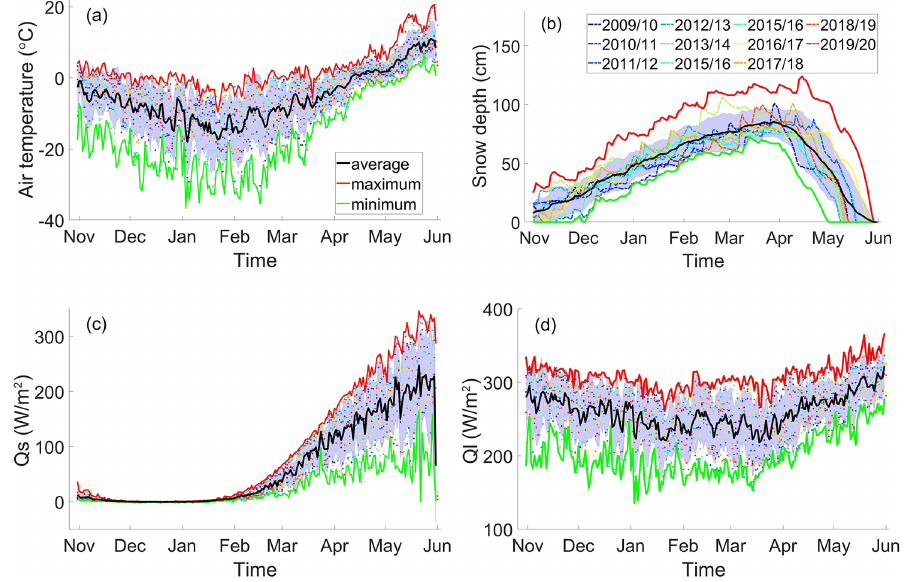
Figure 7. The observed (dots) daily mean air temperature (a) , snow depth (b) , downward shortwave radiative flux (c) , and longwave radiative flux (d) for each ice season between 1 November and 31 May. The solid lines represent decadal daily maximum (red), minimum (green), and average (black) values. The shadow area represents the standard deviation (SD). For snow depth, daily mean values are given as thin colour lines. Table 2. Summary of various meteorological and physical observations between 1 November and 31 May. For meteorological parameters ( V a , T a , RH, cn, Q s , Q l ) the values are seasonal mean ± standard